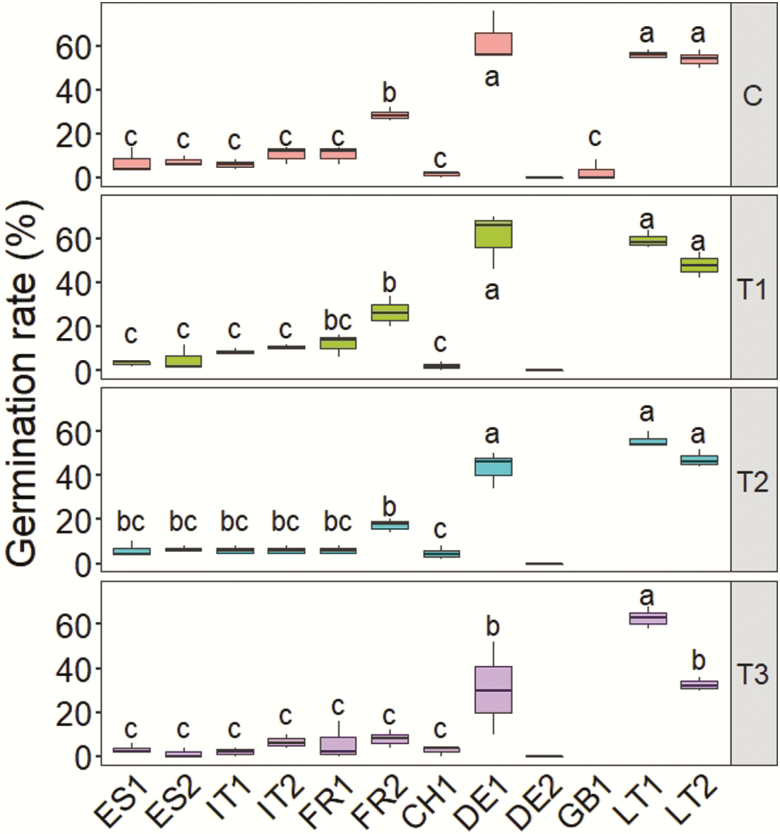
Germination rates for 14 Betula pendula populations in controlled chamber conditions under four treatments: a control without pre-chilling (C) and pre-chilling treatments with a duration of 15 days (T1), 30 days (T2) and 45 days (T3). Population GB1 was only tested in the control treatment (C) due to low seed availability. Means that do not share letters indicate significant differences among populations within treatments (P < 0.05, Tukey test). Boxes show the median (inside line), the interquartile range (hinges are the 25th and 75th percentiles) and 1.5 times the interquartile range (whiskers). Populations are ordered by latitude (codes as in Table 1).